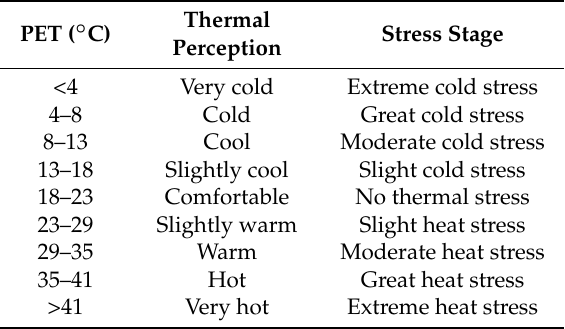
Table 1. Physiologically equivalent temperature (PET) evaluation scale (Matzarakis and Mayer 1996; modified).